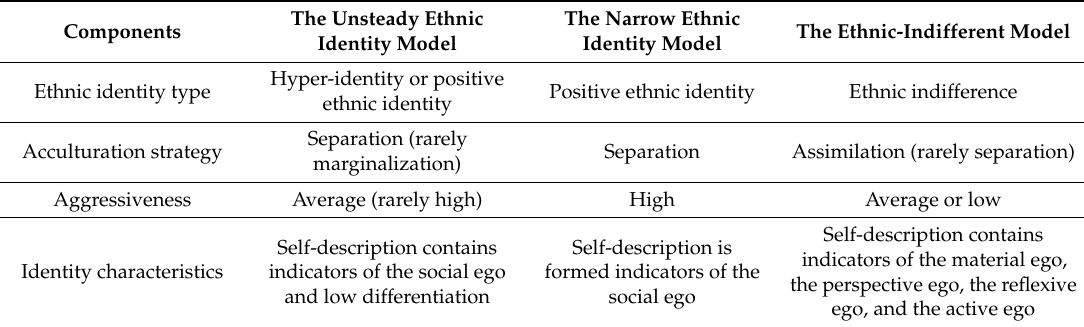
Table 5. Components of personal identity models in